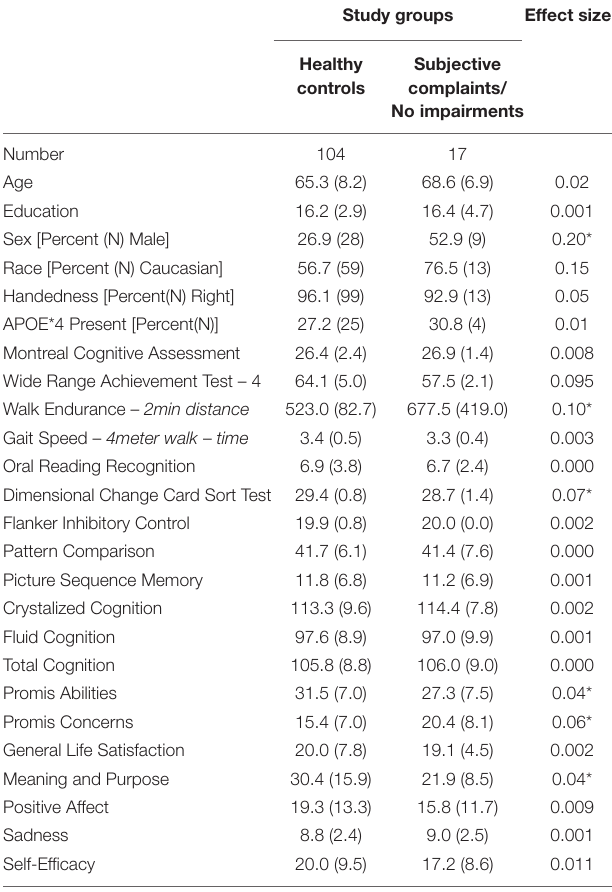
TABLE 2 | Characteristics of cognitively normal participants by